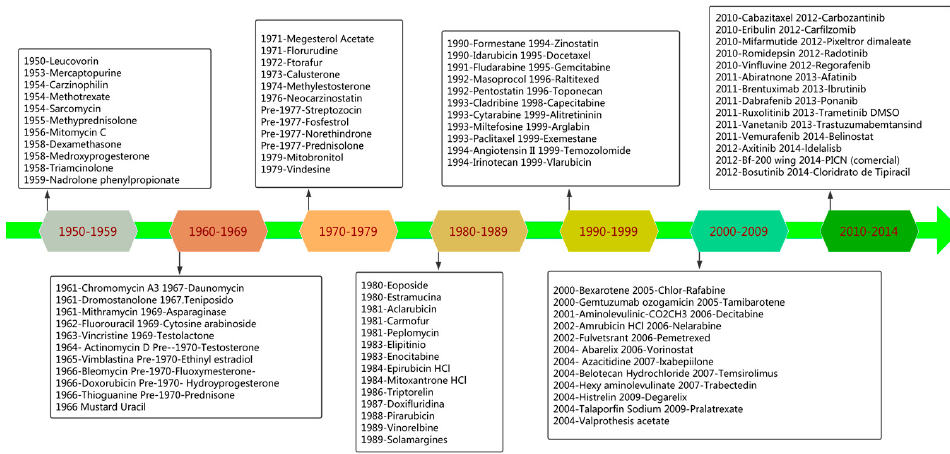
Figure 4. Approved marketed anticancer drugs from 1950 to 2014 which are directly obtained or derived from natural products or imitate them (adopted from [428], licensed under creative common attribution license). Table 2. Natural products undergoing clinical trials for the prevention/treatment of various cancers.